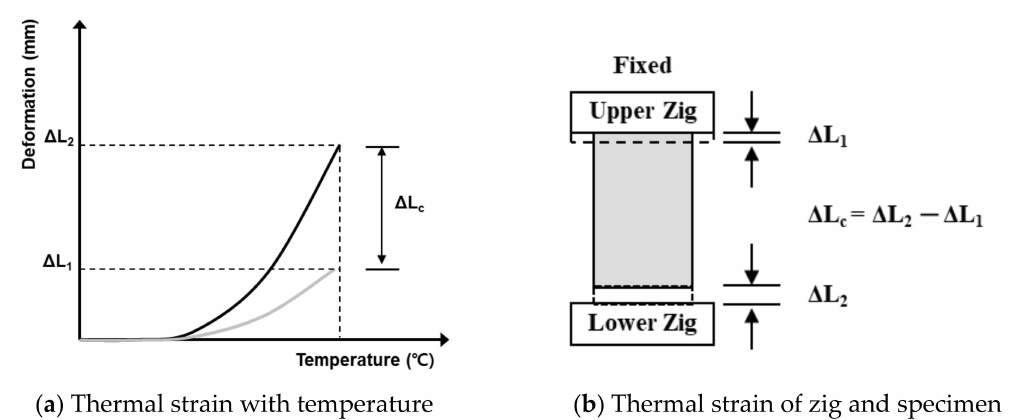
Figure 6. Test method for determining the thermal